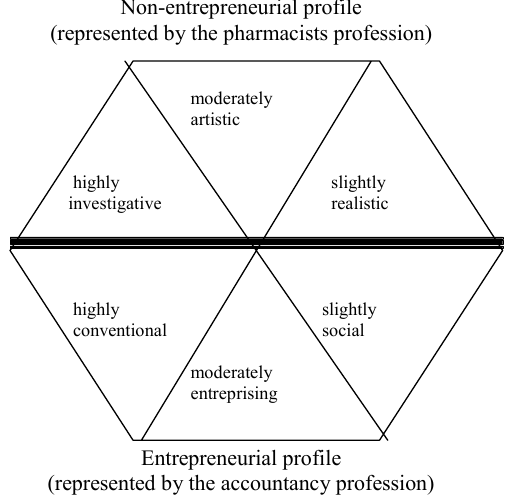
Holland’s (1985) hexagon of occupational